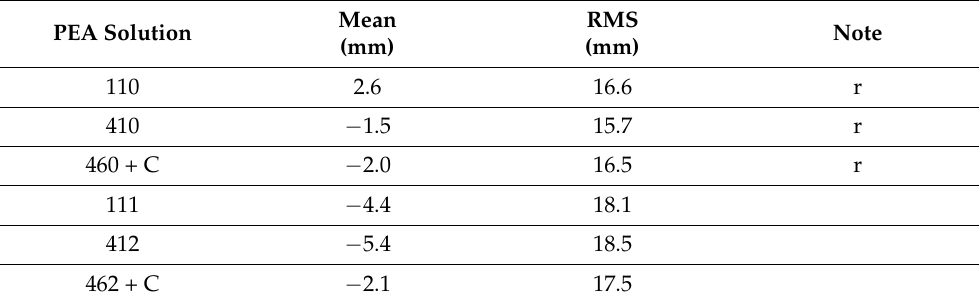
Table 3. SLR residuals of different PEA strategies in POD. The SLR measurements were obtained from 11 individual ILRS stations and used in validations of the HY-2B orbit.